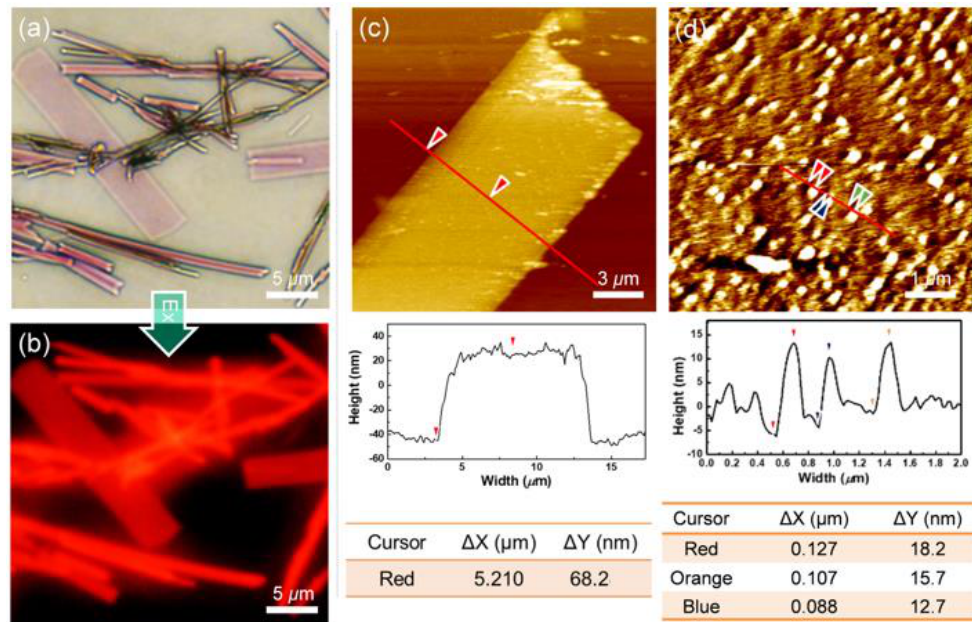
Figure 5. ( a ) OM and ( b ) FOM images of 3Bu belts and sheets obtained from 25 µ M THF-H 2 O (1/1, v / v ) at 10 – 15 °C. ( c ) AFM image showing 3Bu microsheet on a glass substrate and height profile. ( d ) Magnified AFM image showing spherical nanoparticles on 3Bu microsheet and height profile.